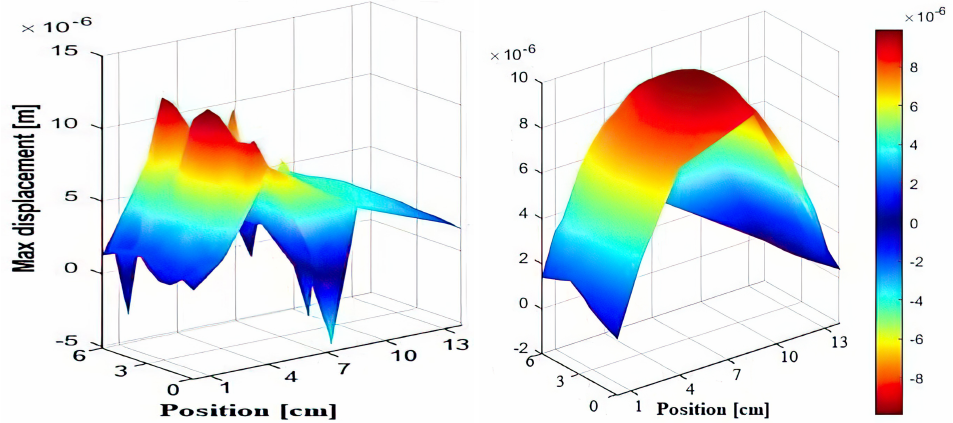
Figure 5. Vibrometer displacement data of Teflon ( left ) and Gorilla Glass ( right ). For all three tests, an identical signal was used, the only change being the overlay material. This data would indicate that Teflon is the most effective at increasing the localization of seismic wave signal